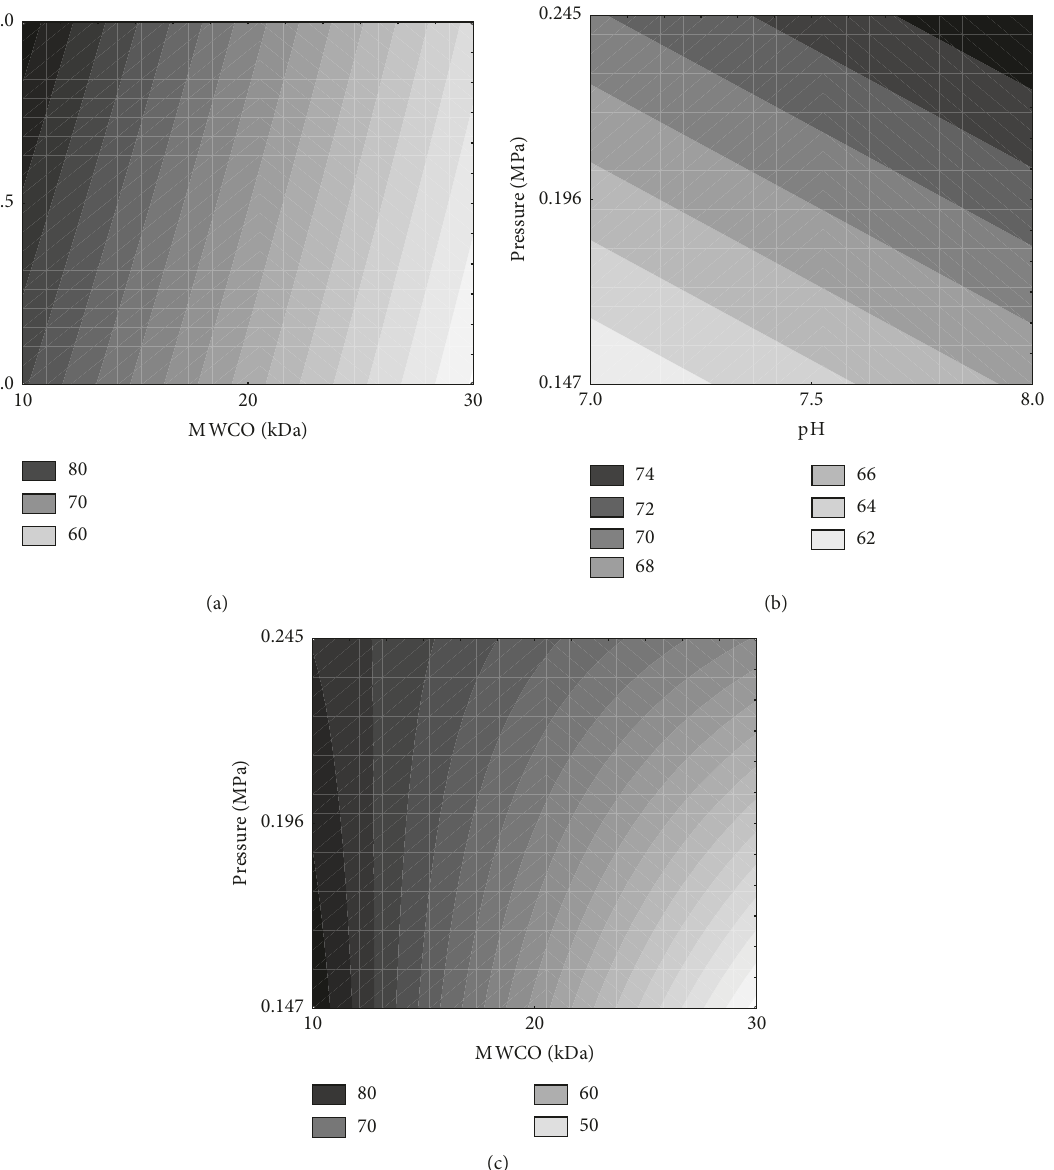
Figure 3: Contour curves for the recovery of enzyme as a function of (a) pH and MWCO, (b) pH and the operating pressure, and (c) MWCO and operating